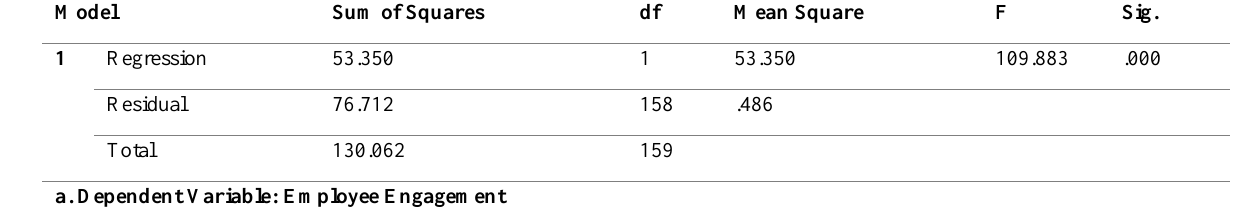
Table 3: ANOVA for job resources on work